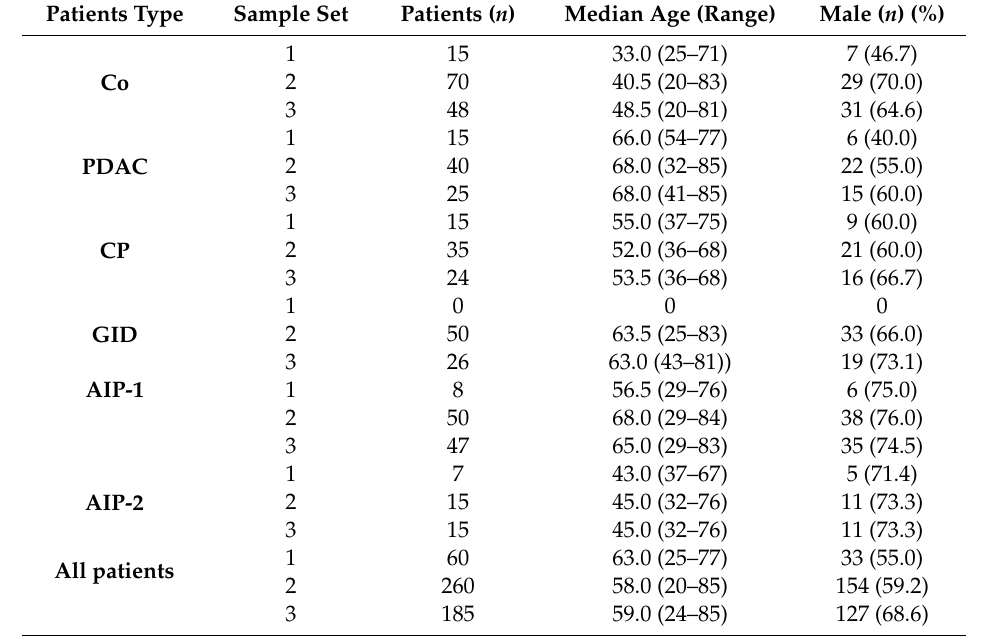
Table 1. Patient data in the three sample sets used for protein microarray profiling, n : number of observations.